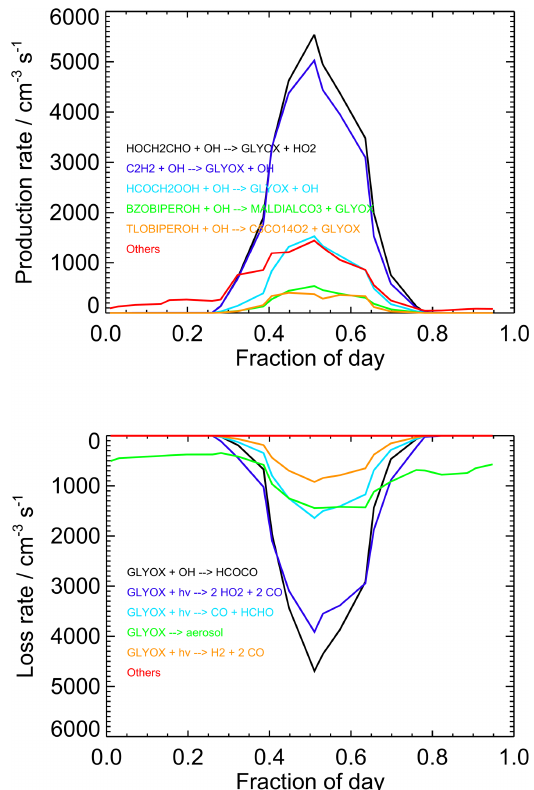
Figure 10. Diurnally averaged glyoxal budgets for the base model run for both measurement periods combined. Chemical names are as given by the MCM. For information on molecular formulae and details of production mechanisms of BZOBIPEROH and TLO- BIPEROH, please see http://mcm.york.ac.uk/roots.htt#aromatics (last access: 12 April